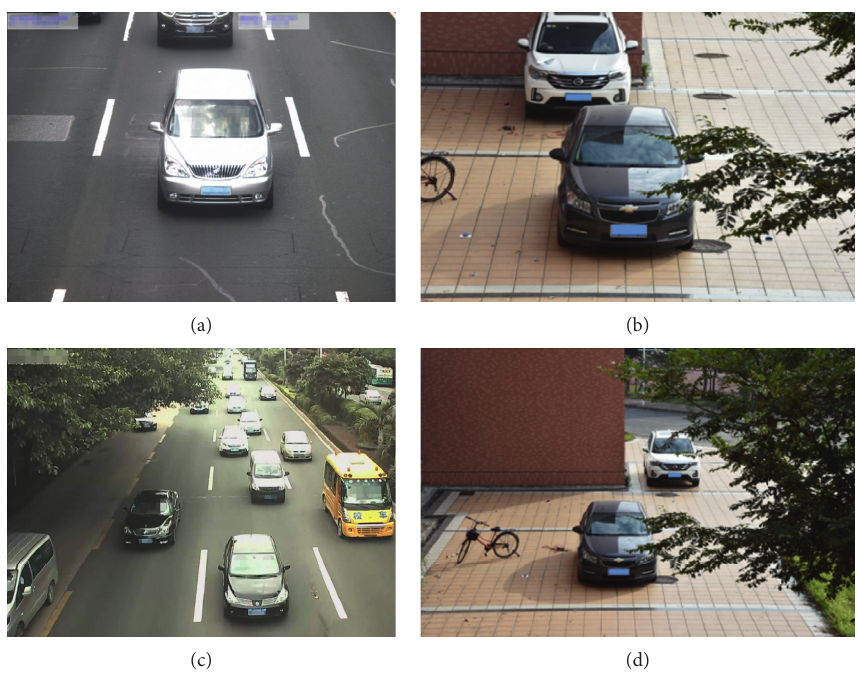
Figure 11: Examples of scenes in the two main traffic video road surveillance systems and the simulation experiment in our paper. (a) A common VIC scene. (b) A simulated experimental VIC scene. (c) A common RVS scene. (d) A simulated experimental RVS scene.